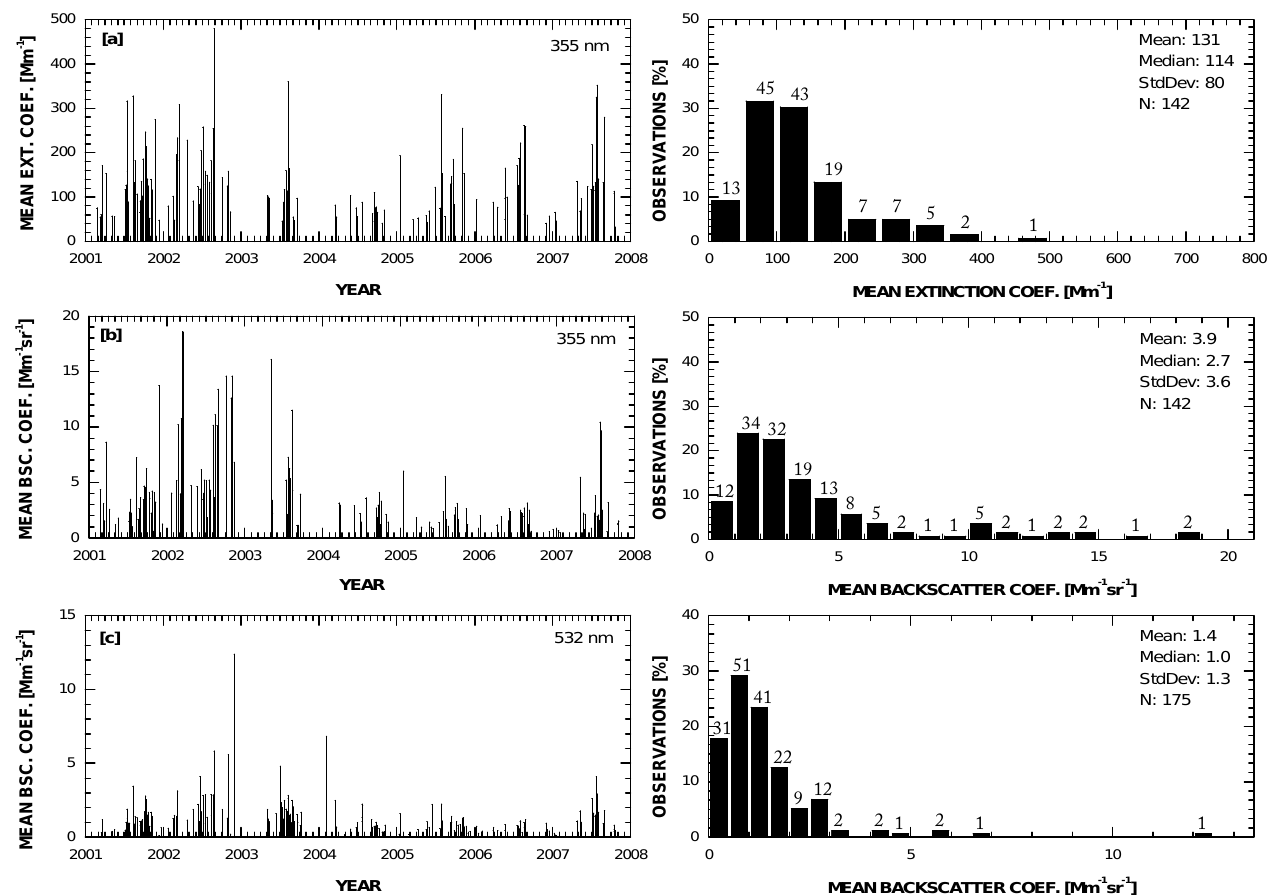
Fig. 1. (a) Mean extinction coefficient at 355nm, (b) mean backscatter coefficient at 355nm, (c) mean backscatter coefficient at 532nm and the corresponding frequencies of occurrence of